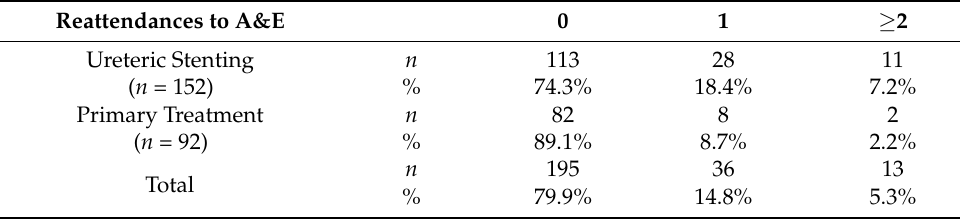
Table 2. Number of Reattendances to Emergency